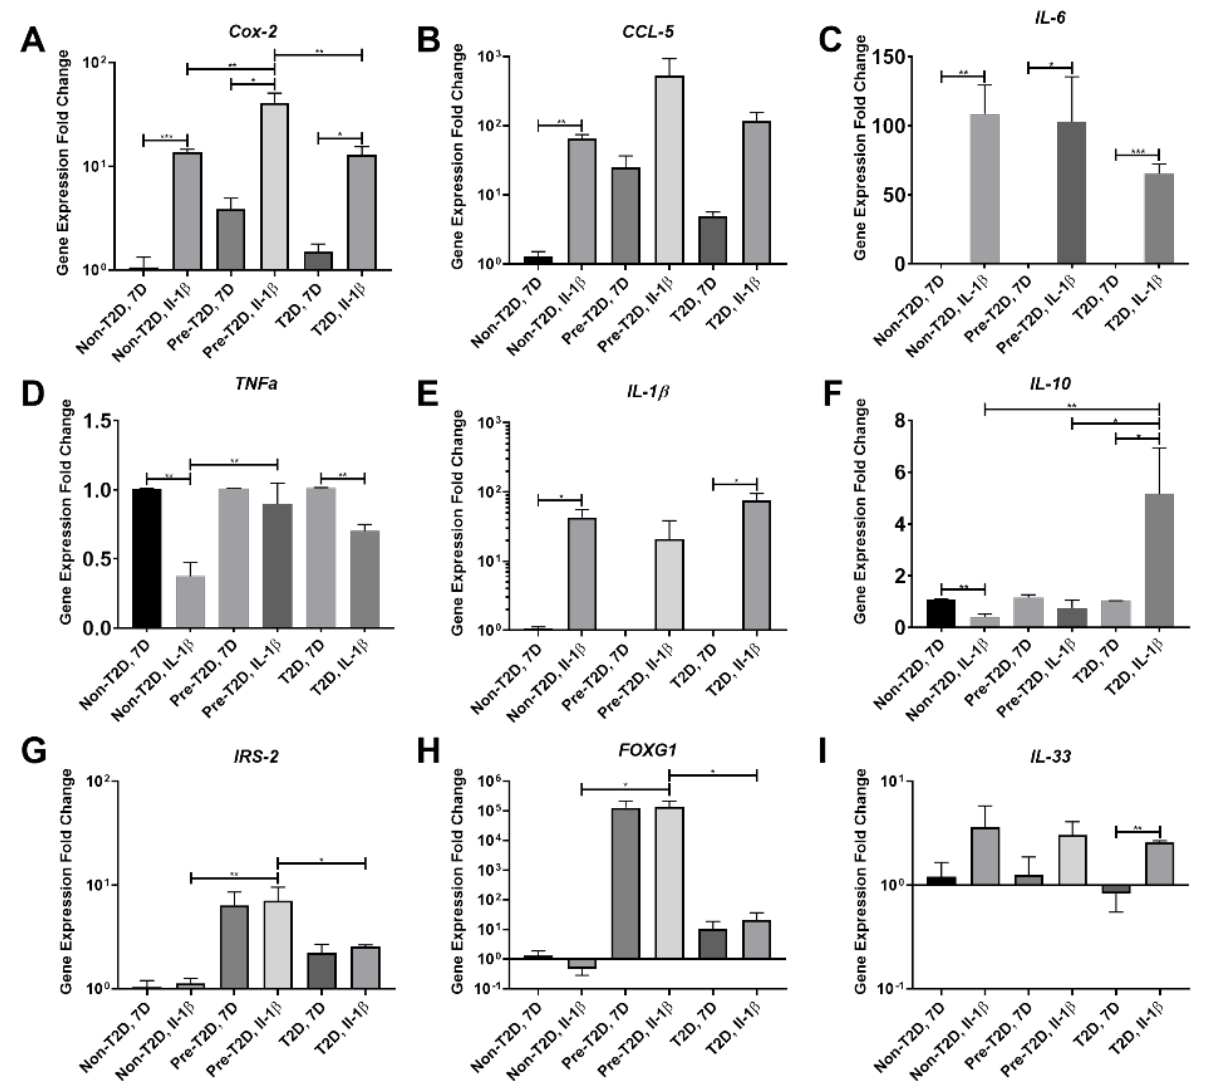
Figure 4. ( A–I ) Increased expression of COX-2 in Pre-T2D IPFP-ASCs compared to Non-T2D and T2D IPFP-ASCs before and after IL-1 β treatment. ( n = 3, * p < 0.05, ** p < 0.01, *** p < 0.001). Non- T2D: Non-Type II diabetes mellitus, Pre-T2D: Pre-Type II diabetes mellitus, T2D: Type II diabetes mellitus.